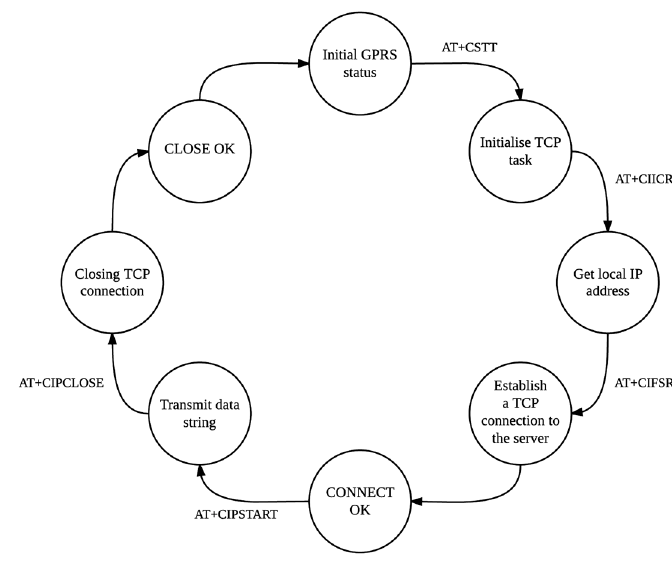
Figure 2. State machine showing the different states of the GSM connection process. Table 2. The AT commands used for data transmission and reception.